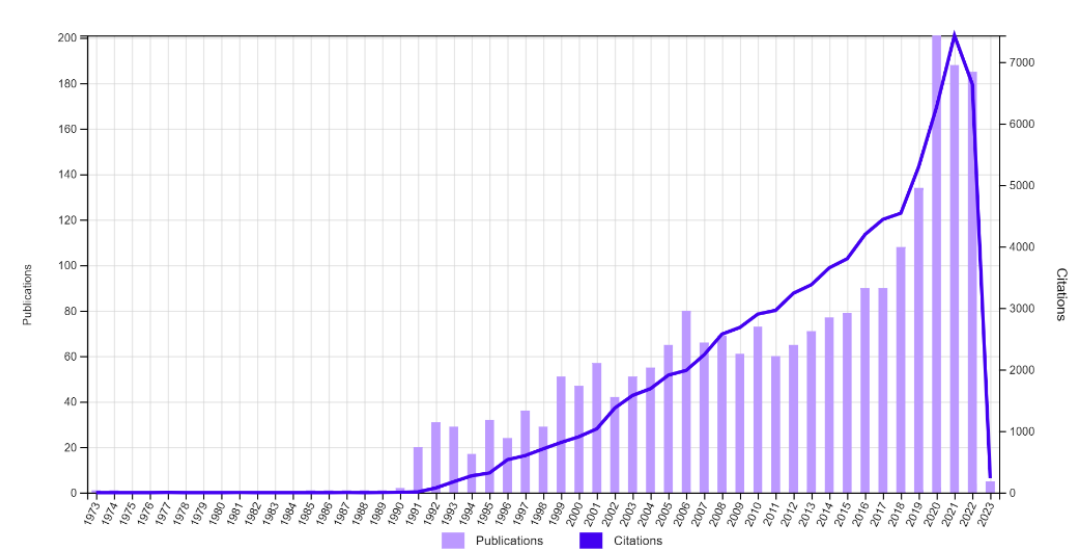
Figure 1. Popularity of Escape Room studies (Generated from Web of